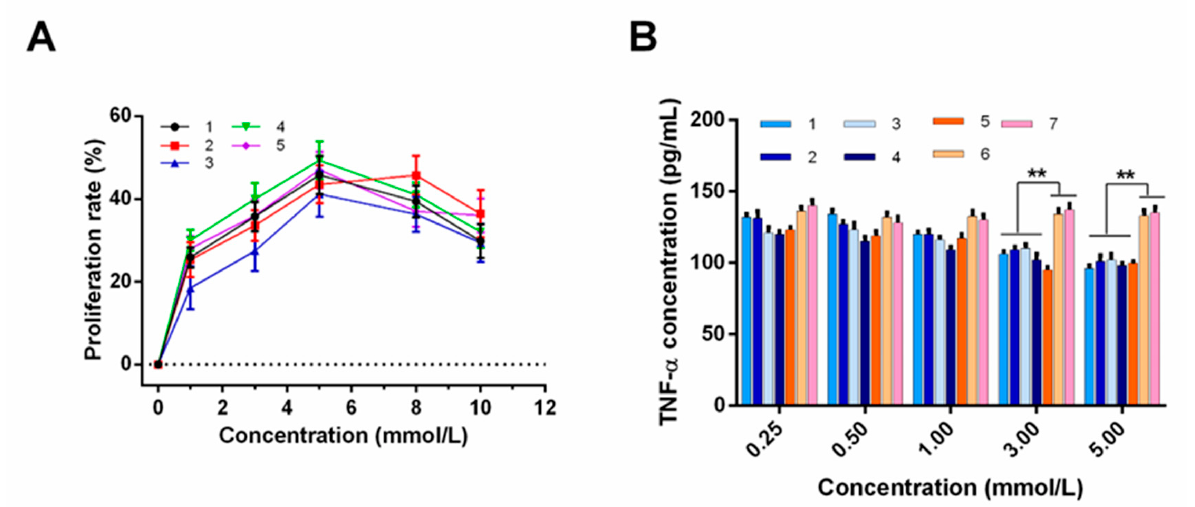
Figure 2. Immunoactivity test of the five synthetic peptides. ( A ) Cell proliferation rate at different concentrations of peptides. ( B ) Effect of different peptide concentrations on the secretion of TNF- α in B lymphocytes. Data are presented as the mean ± SD ( n = 6). **, p < 0.01 versus control group.1-RYPLGYL, 2-KHPIKH, 3-KHPIK, 4-FFSDK, 5-YGG, 6-control group, 7-blank group